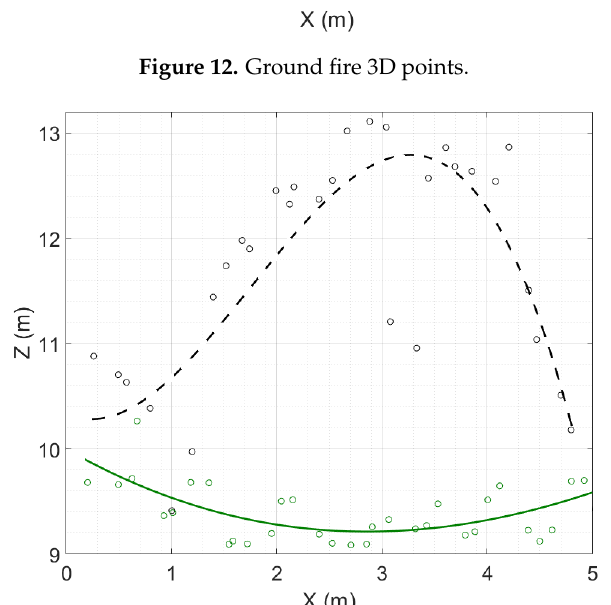
Figure 13. Front line (dashed black line) and back line (solid green line) of the the fire presented in Figure